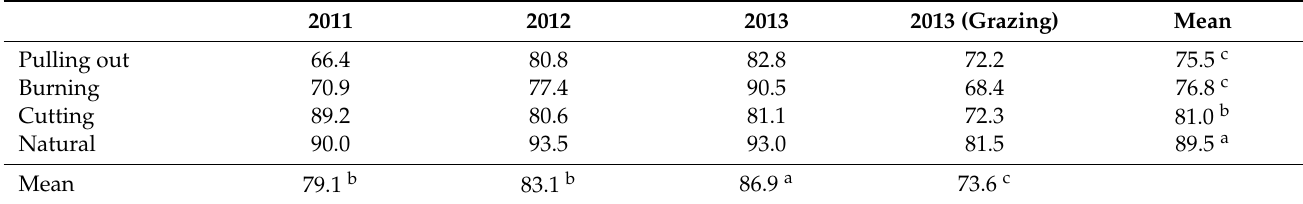
Table 2. Plant cover of improved and grazed rangeland